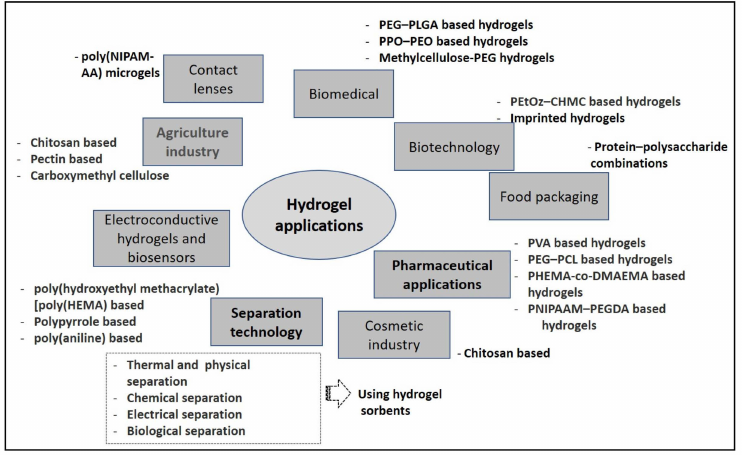
Figure 3. Various applications of hydrogels. The texts were extracted from Ref.